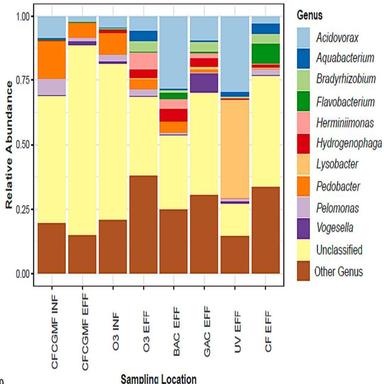
Relative abundance of top 10 genera across the treatment train.